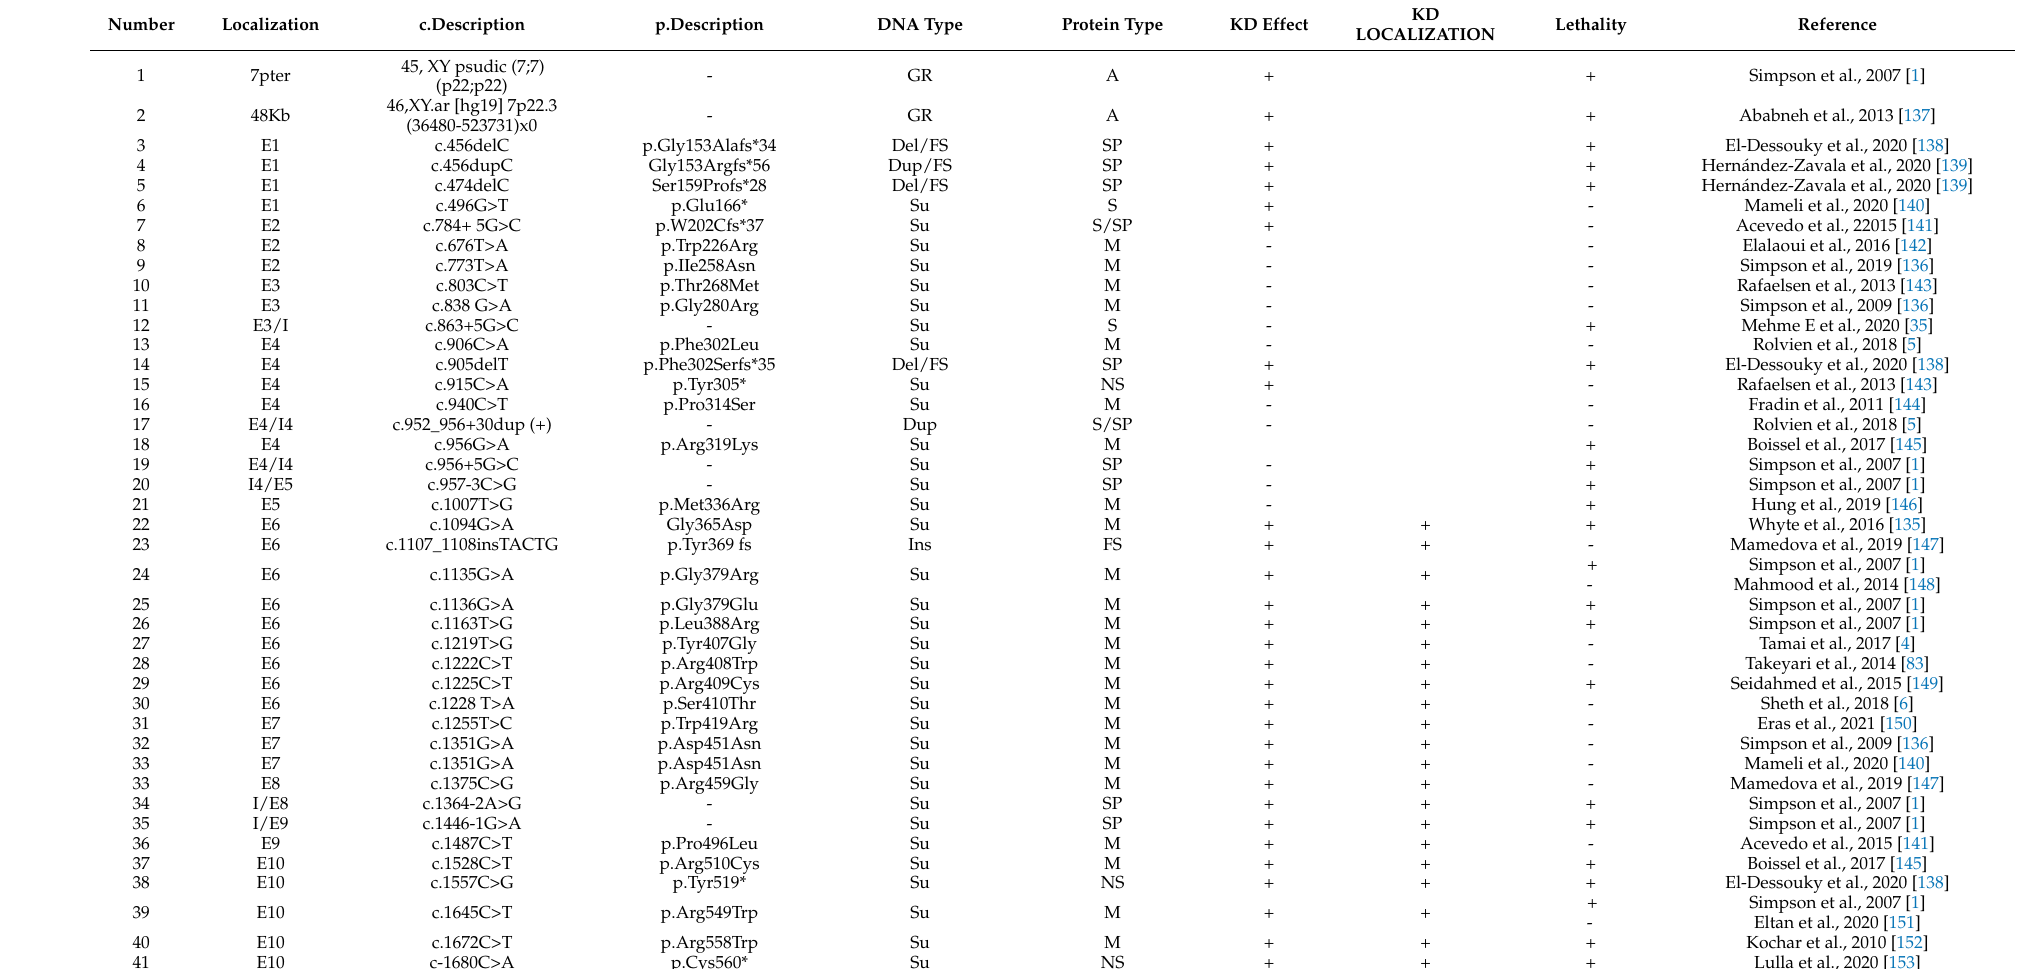
Table 2. Pathogenic FAM20C variants in lethal and non-lethal